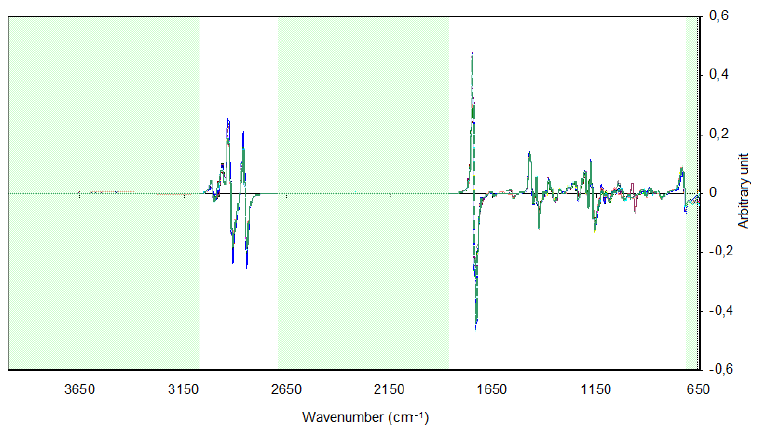
Figure 2. UATR-FTIR spectra of samples of biodiesel with the application of the first derivative and the SNV. The excluded regions of the spectra are highlighted.